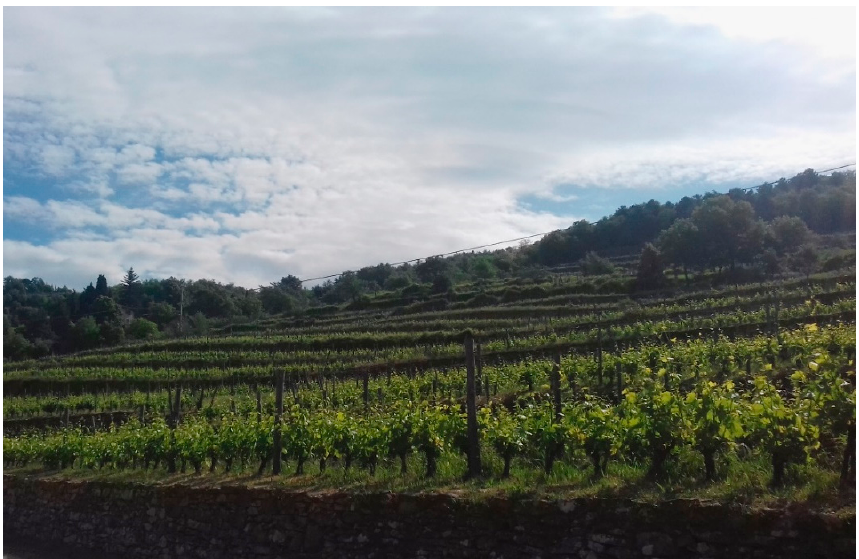
Figure 1. Vigna Grospoli vineyard in Lamole. Photo by G. Castelli.